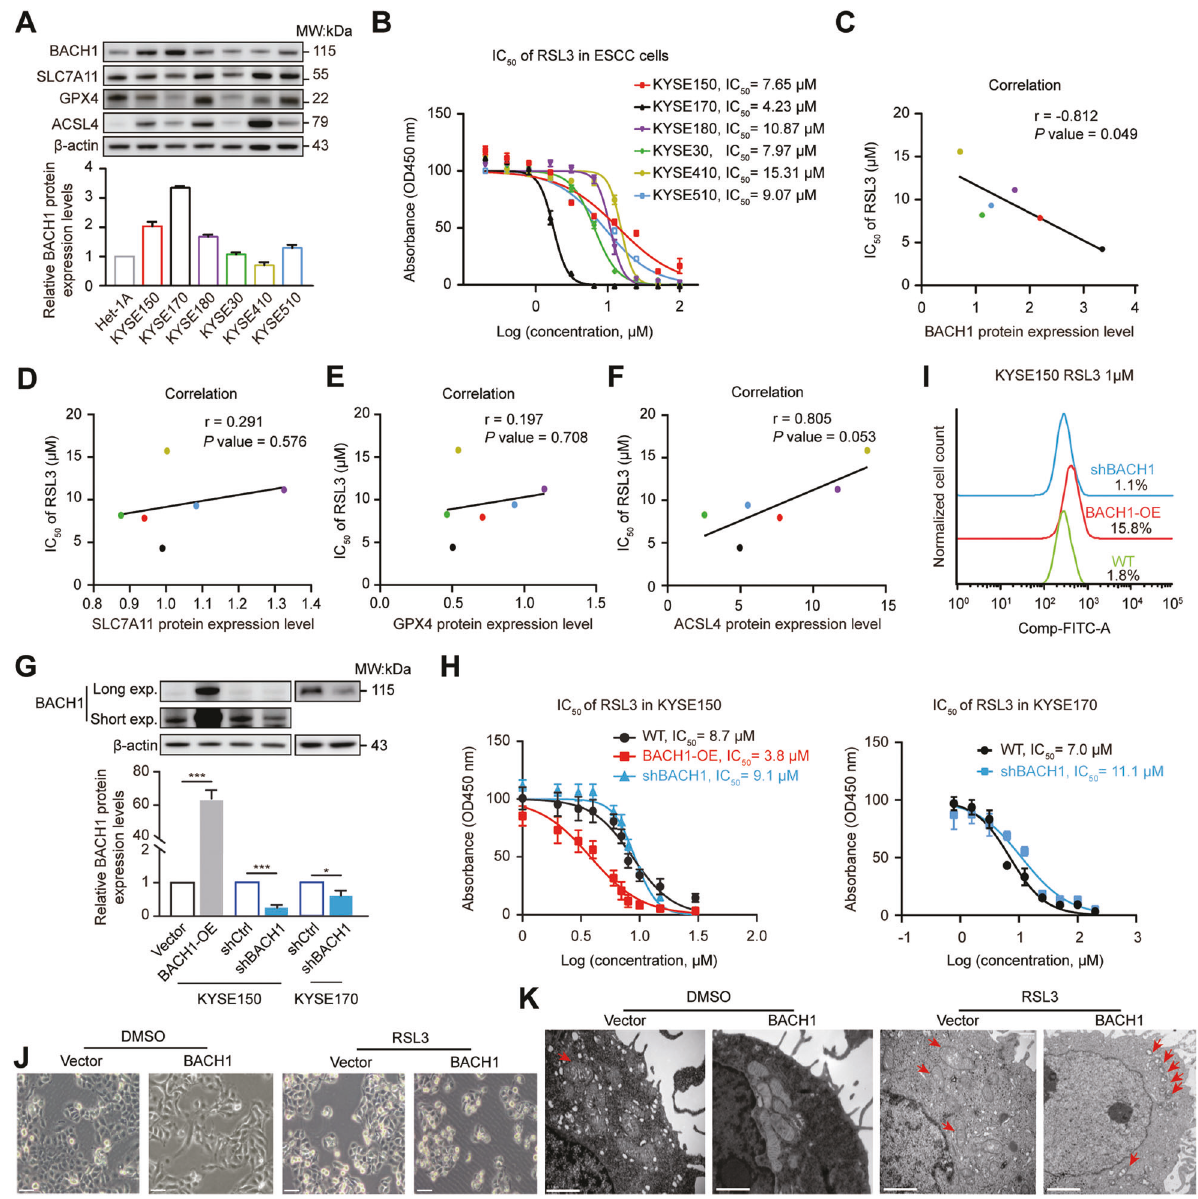
Fig. 3 BACH1 affects the sensitivity of ESCC cells to ferroptosis. A Relative expression of the BACH1, SLC7A11, GPX4, and ACSL4 proteins in esophageal epithelium Het-1A and ESCC (KYSE150, KYSE170, KYSE180, KYSE30, KYSE410 and KYSE510) cells as determined by western blotting. β -actin was used as a loading control. B Concentration – response plot of different ESCC cells to RSL3, a ferroptosis-triggering agent, as determined by CCK-8 assay with measurement of the absorbance at 450 nm. C-F Correlations between BACH1 ( C ), SLC7A11 ( D ), GPX4 ( E ), and ACSL4 ( F ) protein expression levels ( A ) and their relevant IC 50 values of RSL3 ( B ) against ESCC cells. G Lentivirus-mediated stable ectopic expression (BACH1-OE and shBACH1) and knockdown (shCtrl and shBACH1) of BACH1 in KYSE150 and KYSE170 cells. The ef fi ciency of overexpression and knockdown was determined by western blotting. Long and short exposures (exp.) of the BACH1 blots are shown for KYSE150 cells. H Forced expression of BACH1 decreased the IC 50 value of RSL3 against KYSE150 cells (left panel), whereas knockdown BACH1 knockdown increased the IC 50 value of RSL3 against KYSE170 cells (right panel). I Flow cytometric analysis after C11-BODIPY 591/581 staining showed the changes in lipid peroxidation after transient perturbation of BACH1 followed by treatment with 1 µM RSL3 in KYSE150 cells. J Phase-contrast microscopic changes in cellular shape in the absence (DMSO) or presence of 1 µM RSL3 for 6 h. K Ultrastructural changes in vector control and BACH1-OE cells as determined through transmission electron microscopy after incubation in the absence or presence of 1 µM RSL3 for 6 h. The red arrows indicate mitochondria. Scale bar, 0.5 μ m. BACH1 inhibits monounsaturated fatty acid (MUFA) the popliteal lymph nodes (16.7% vs. 83.3%), while the use of biosynthesis to induce ferroptosis Liprox-1 had no signi fi cant effect (Fig. 4I, J). Taken together, the To assess the mechanisms underlying BACH1-induced ferroptosis results indicate that BACH1 facilitates lymph node metastasis but and lymph node metastasis, we performed RNA sequencing inhibits hematogenous metastasis of ESCC in a ferroptosis- analysis on control and KYSE150-BACH1-OE cells. Kyoto Encyclo- dependent manner, while ferroptosis itself inhibits the growth of pedia of Genes and Genomes enrichment analysis revealed that subcutaneous tumors while promoting lymph node metastasis. Cell Death and Disease (2023)